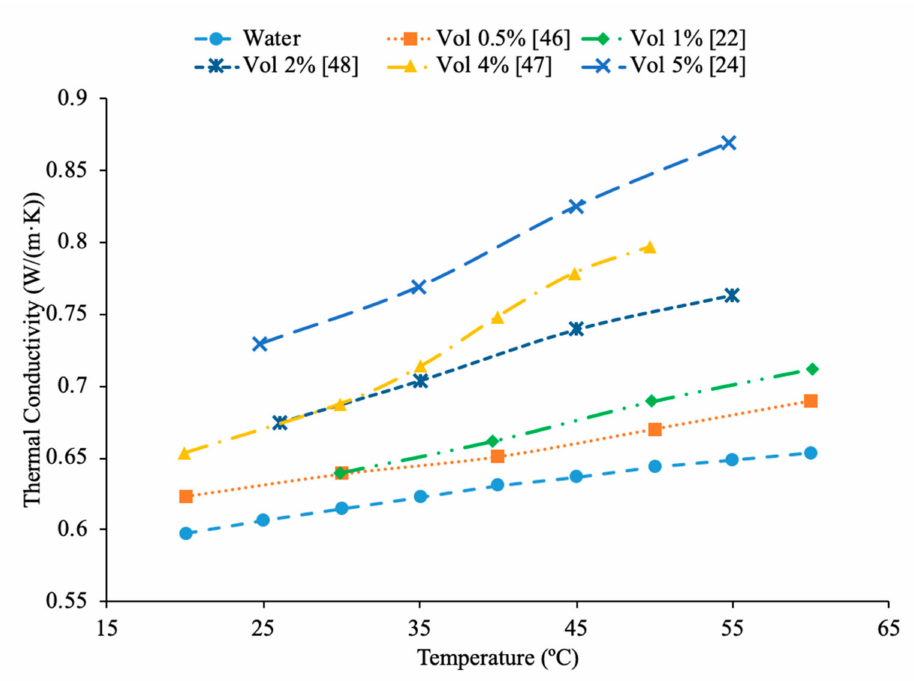
Figure 15. Thermal conductivity of Al 2 O 3 –water nanofluids as a function of temperature